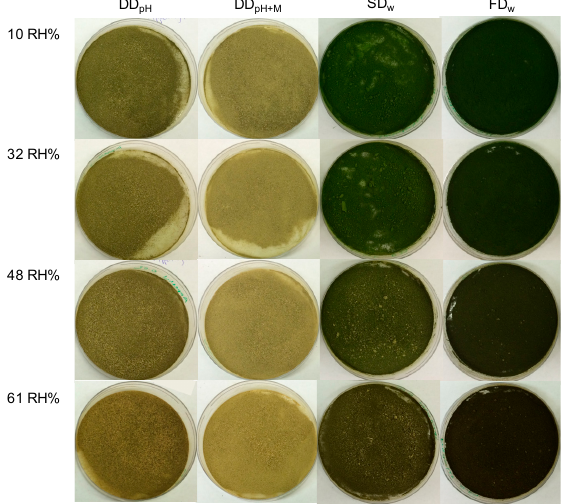
Figure 2. Photography of thylakoid powders produced in different ways after 8 months storage in controlled atmosphere with different relative humidity. DD pH = drum-dried powder produced by the pH method, DD pH+M = drum-dried powder produced by the pH method with addition of maltodextrin, SD w = spray-dried powder produced by the water method, FD w = freeze-dried powder produced by the water method.